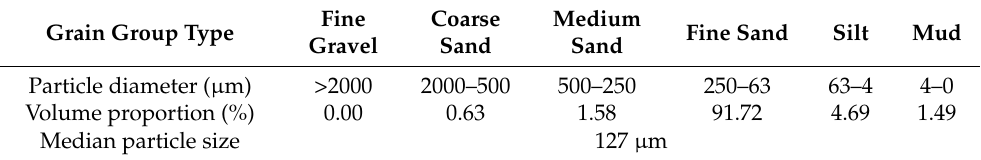
Table 1. Particle size classification of the natural